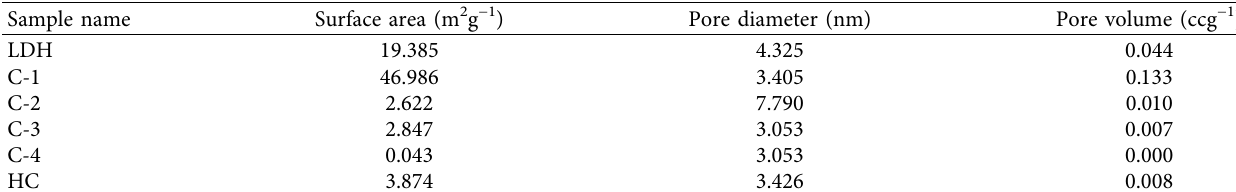
Figure 4: N 2 adsorption-desorption isotherm (a) and pore size distribution (b) of various materials (LDH, C-1 to C-4, and HC). Table 2: Porosity data of various materials as obtained through nitrogen adsorption